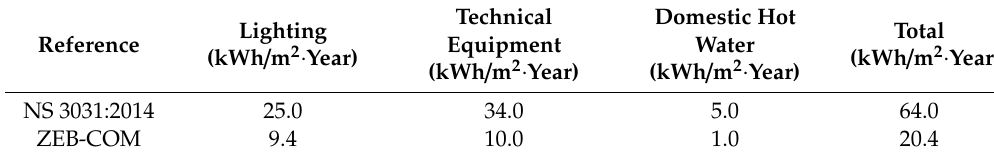
Table 3. NS 3031 energy consumptions for building end-uses and ZEB Lab